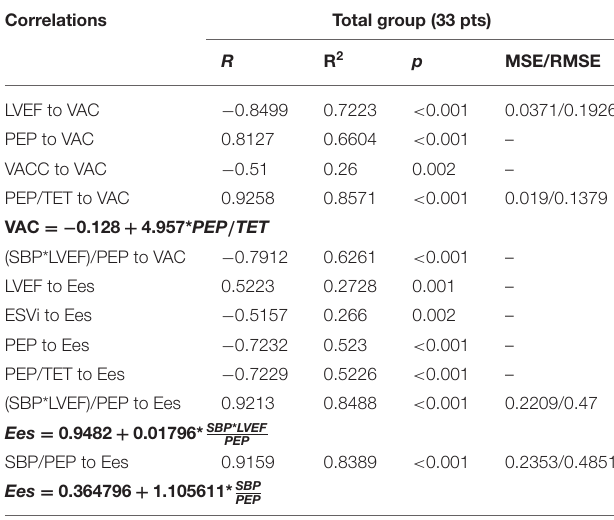
TABLE 3 | Correlation analysis in the overall group between main hemodynamic